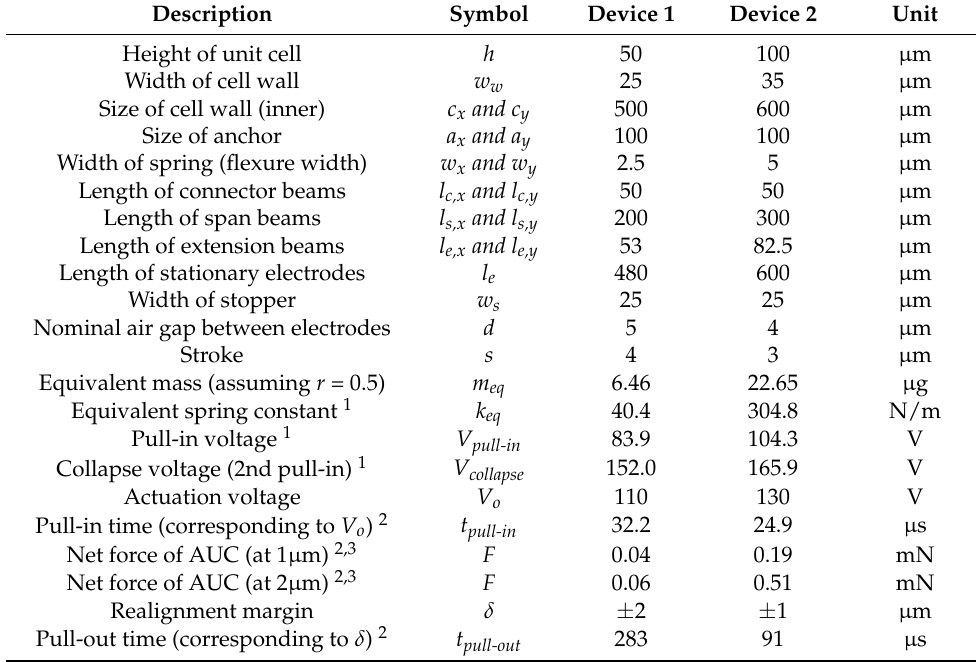
Table 2. Examples of proposed AUC geometries for fabrication and their estimated performance characteristics. Absent AUC parameters have the same values as those listed in Table